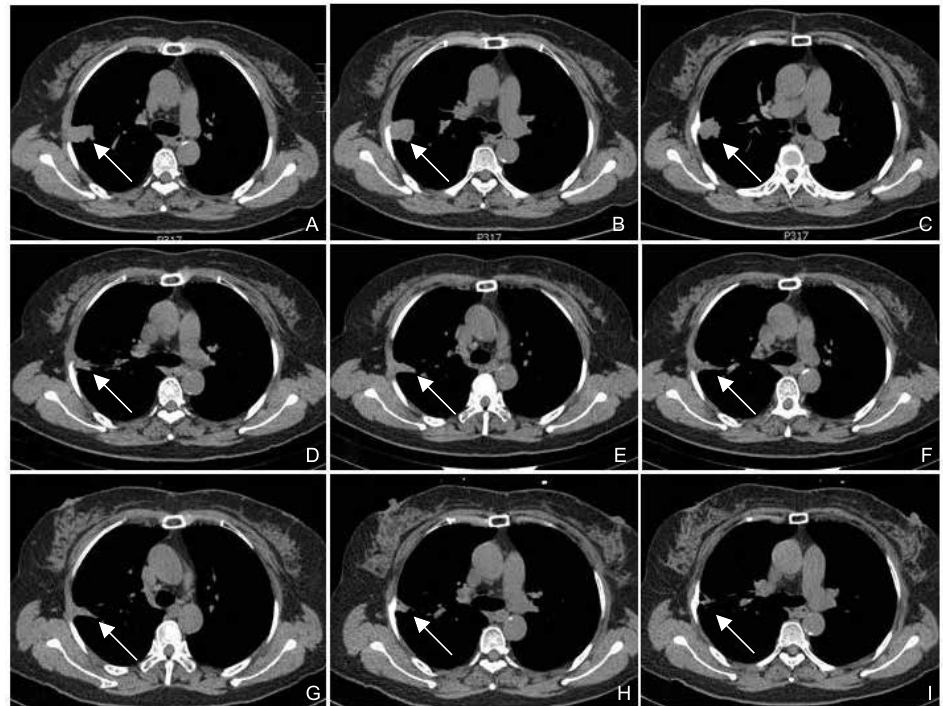
Figure 1 Pulmonary CT image in a 71-years-old woman with pulmonary metastasis. The pre-ablation pulmonary CT shows a low density and irregular lesion with 2.8cm in the right upper lobe near chest wall (A, B and C). The pulmonary CT at post-ablation 7 months shows the tumor become small significantly (D, E and F). The pulmonary CT at post-ablation 14 months shows the ablation zone turned into a scar (G, H and